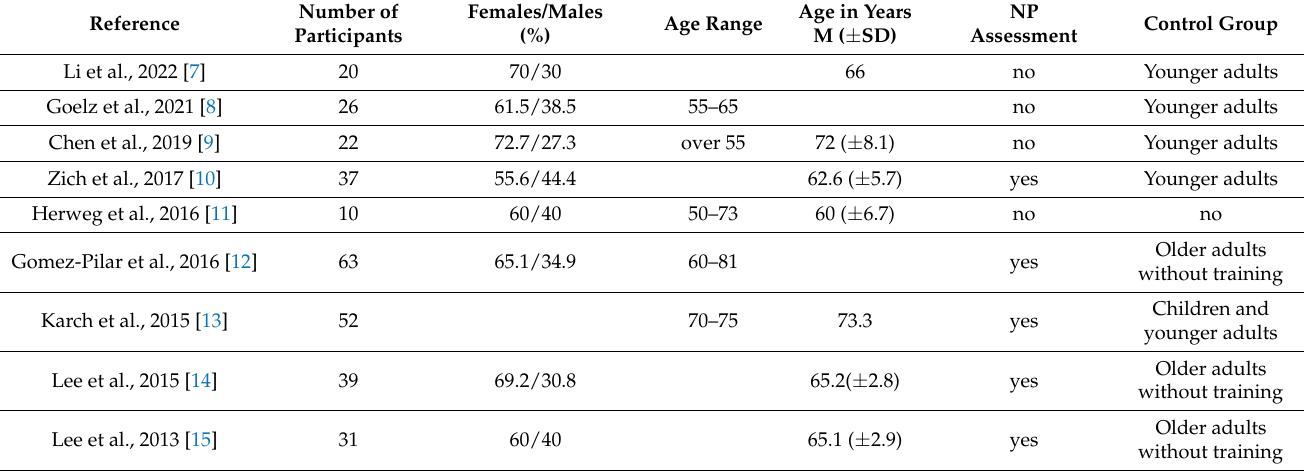
Table 1. Participants’ characteristics in the included studies. Notation: NP = neuropsychological; M = mean; SD = standard deviation.